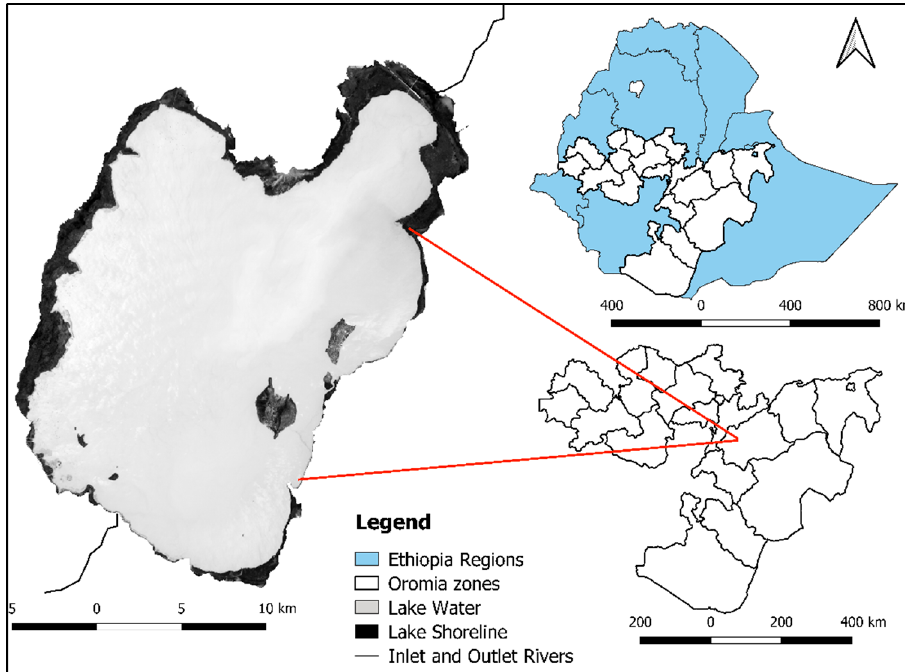
Figure 1. Map of Lake Ziway and the surroundings.